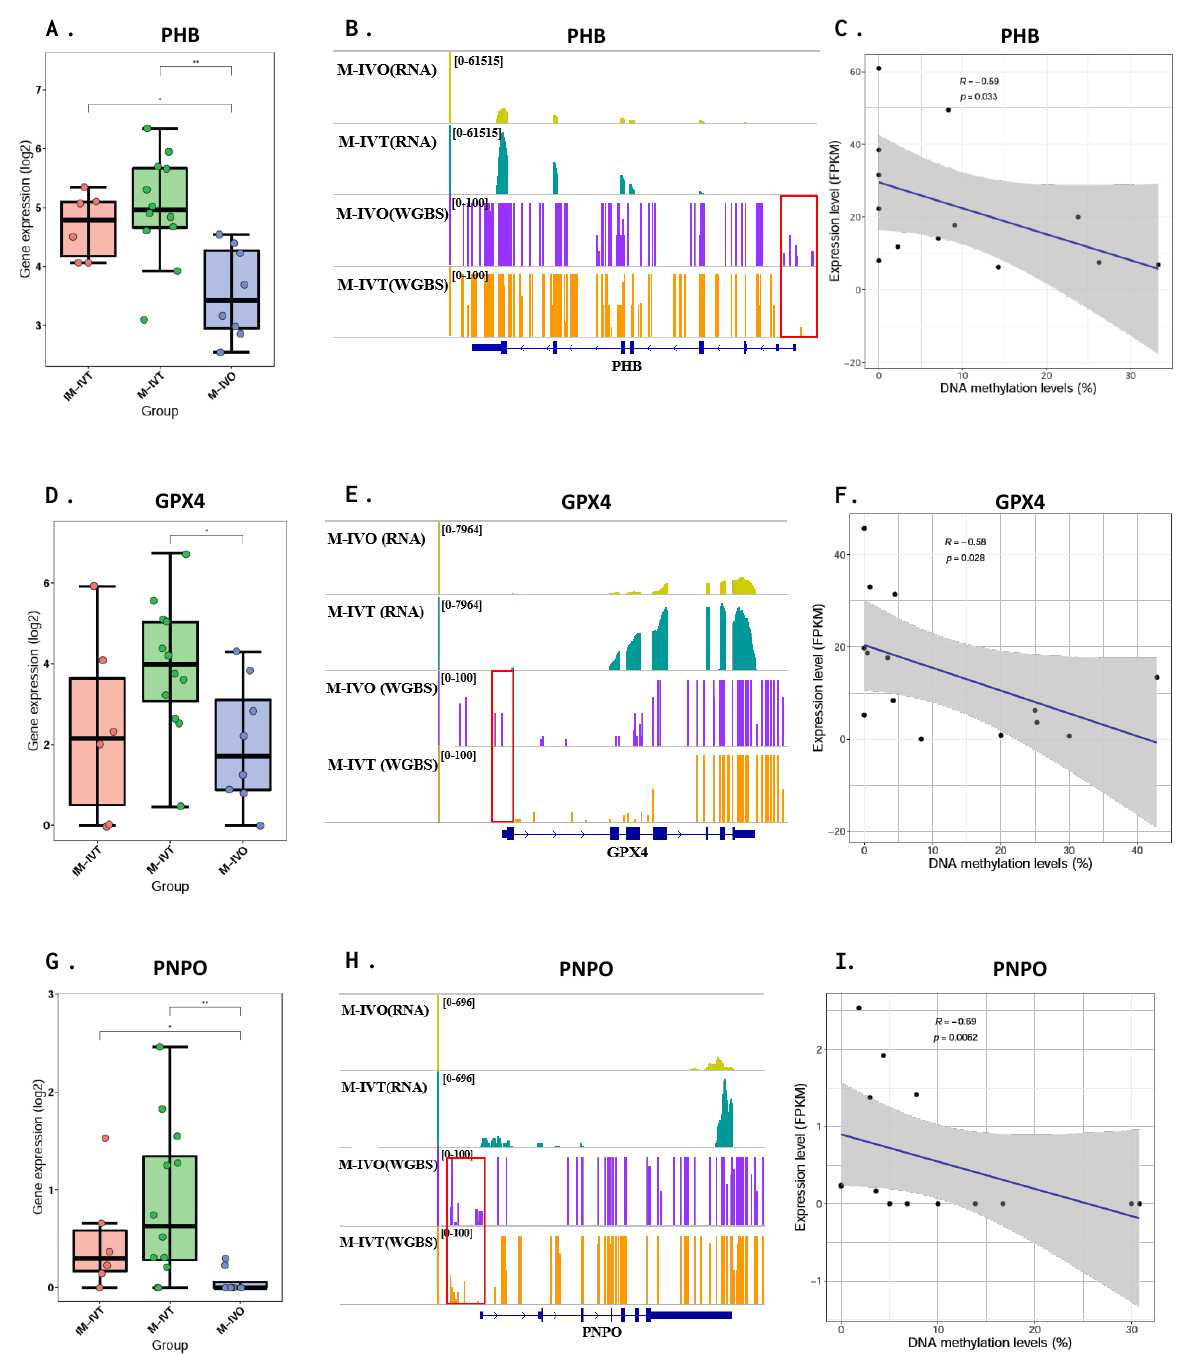
Figure 6. Increased mRNA expression level of PHB, GPX4, and PNPO were correlated with the methylation level of their promoter region. The gene transcript expression level of PHB ( A ), GPX4 ( D ), and PNPO ( G ) in oocytes from IM-IVT group, M-IVT group and M-IVO group. Browser view of RNA-seq and bisulfite-seq signals on the gene PHB ( B ), GPX4 ( E ), and PNPO ( H ) in the IM-IVT and M-IVO. The scale of normalized reads is shown for the RNA-seq data. The scale of DNA methylation ratio is shown for the bisulfite-seq data. For PHB ( C ), GPX4 ( F ), and PNPO ( I ), DNA methylation levels is plotted on the X -axis, while gene expression level (FPKM) is plotted on the Y -axis. ** p < 0.01 and * p < 0.05 by Wilcoxon test ( A , D , G ). Abbreviation: GPX4, glutathione peroxidase 4; PHB, prohibitin; PNPO, pyridoxamine 5’-phosphate